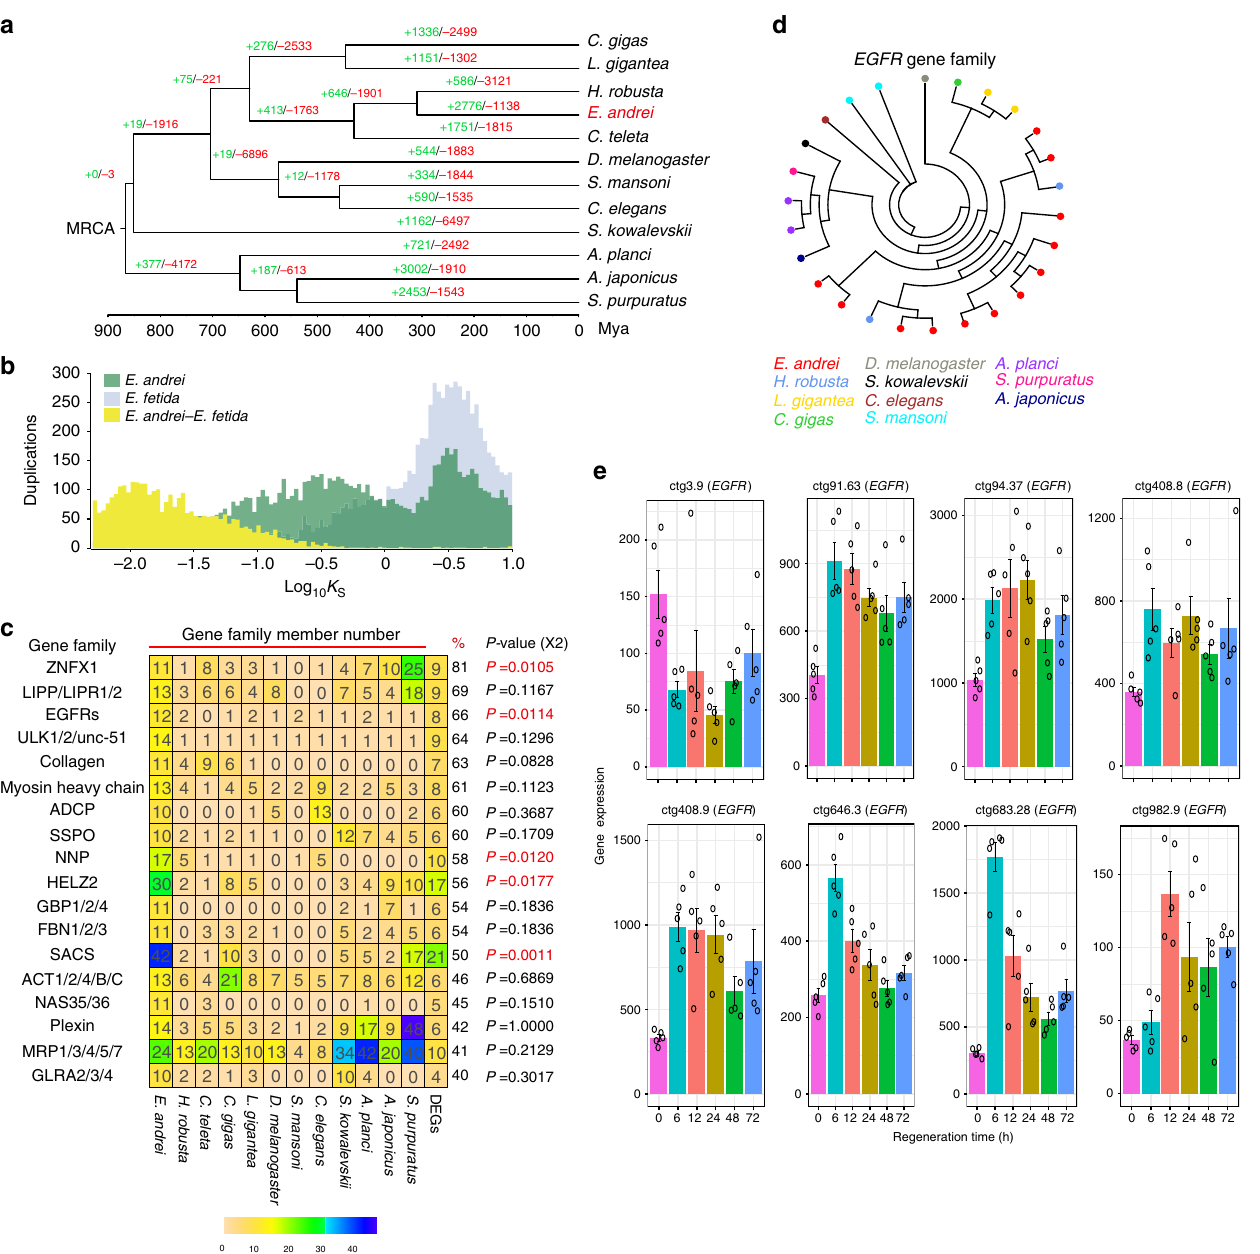
Fig. 4 Evolution of gene families in the earthworm genome. a Expansion/constraction of gene families for 12 invertebates. Expanded gene families were shown in green and contracted gene families in red at the whole genome levels. b E. andrei and E. fetida paranome K S distribution and K S distribution of one- to-one orthologs of E. andrei and E. fetida . We constructed and visualized the K S distribution of paralogs and orthologs using ‘ ksd ’ with default parameters and ‘ viz ’ command in ‘ wgd ’ tools, respectively. c Gene families possessing higher proportions of time-dependently DEGs in regeneration. The numbers in the grids were the copy numbers of the gene families for each species. The % column showed the proportion of DEGs in the speci fi c gene family. And the gene families with higher copy numbers were indicated in dark blue, and the gene families with lower copy numbers were indicated in light yellow. For each candidate gene family, a random test was performed by comparing observed numbers of DEGs in regeneration and randomly numbers by using χ 2 test. The signi fi cant gene families were highlighted with using red p -values. d The epidermal growth factor receptor gene family has a signi fi cant expansion in the earthworm compared to other invertebrates. The earthworm has 12 copies (red color), and the other included species only 1 – 2 copies. Epidermal growth factor receptor ( EGFR ). And diferent species were showed by using diverse colors. e Transcriptomic analyses of EGFRs during regenerative processes in earthworm. For each regenerative stage of each copy included 5 biological replicates ( n = 5). The error bars were showed by using standard error of the mean (s.e.m.). And copies were named by contig ’